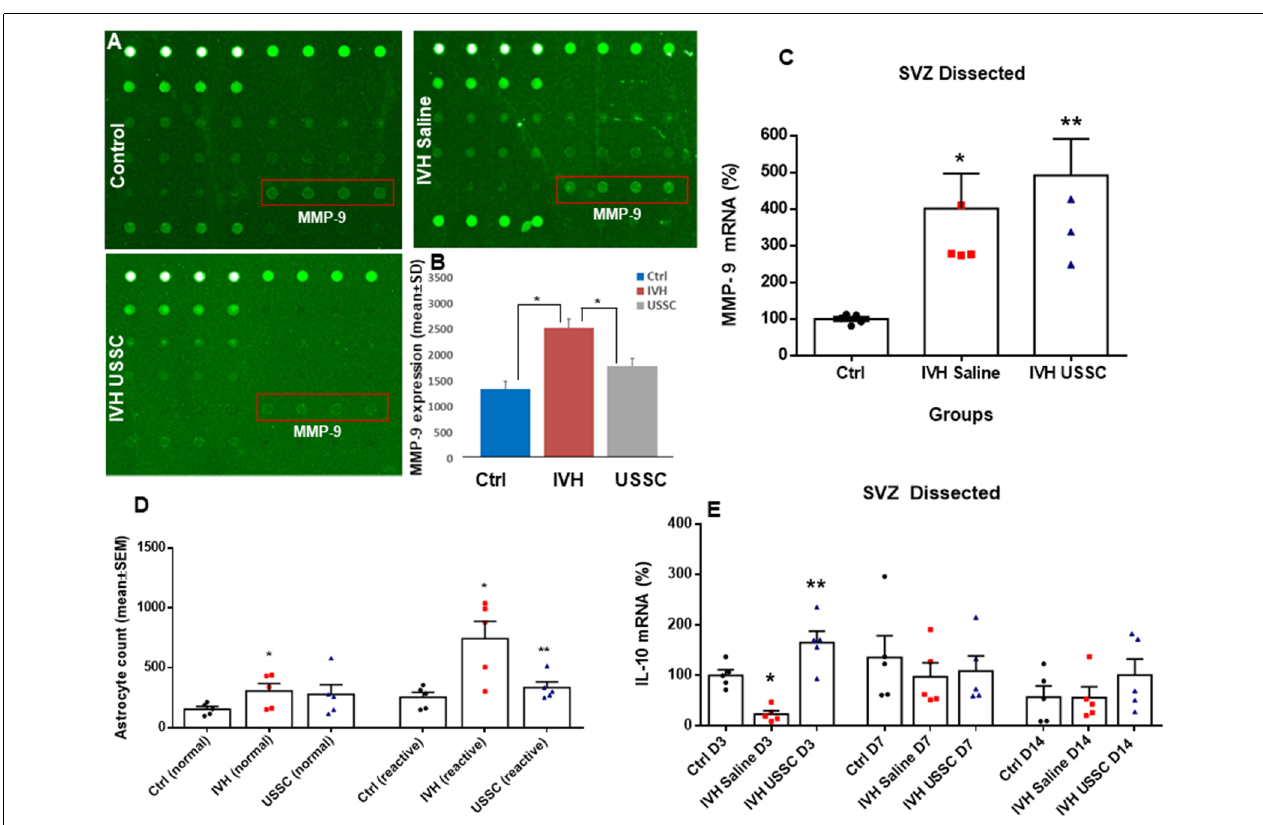
FIGURE 8 | USSC administration suppressed inflammation and enhanced anti-inflammatory cytokine IL-10 mRNA expression in SVZ after PHH. (A) Rabbit cytokine array laser scanned images showing reduced MMP-9 expression after USSC treatment. The representative images are for MMP-9 expression in control, IVH pups with and without USSCs (boxed area = sample loaded as quadruplicates at postnatal day 14). (B) Bar graph shows increased MMP-9 protein expression in IVH pups compared to control pups, whereas USSC treated pups showed significantly reduced expression on postnatal day 14 (* P < 0.05 Ctrl vs. IVH as well as IVH vs. USSC pups, n = 5 pups in each group). The data represent mean ± SD. Assay using rabbit cytokine Array (Ray Biotech., Cat #QAL_CYT-1). (C) Scatter plot with bar graph for TaqMan gene expression assay in microscopic dissected SVZ tissue for MMP-9 mRNA was higher in IVH pups with and without USSC treatment on postnatal day 3 (* P < 0.05 for Ctrl vs. IVH and ** P < 0.05 for IVH vs. USSC group, n = 5 pups in each group). The data represent mean ± SEM; for postnatal day 3. P -values were derived by one-way ANOVA with Tukey’s multiple comparisons test. (D) Total astrocyte cell count showing that normal and reactive astrocytes increased in IVH whereas after USSC treatment, a reduction in reactive astrocyte cell density was observed on day 14 (* P < 0.01 Ctrl vs. IVH and Ctrl vs. USSC for normal astrocytes and * P < 0.05 for IVH vs. Ctrl, ** P < 0.05 for IVH vs. USSC both groups for reactive, n = 5 pups in each group). (E) Bar graphs show TaqMan gene expression assay in microscopic dissected SVZ tissue for IL-10 mRNA. IL-10 mRNA reduced in IVH pups compared to no IVH controls on day 3; whereas USSC injected pups with IVH showed significantly enhanced IL-10 mRNA expression (* P < 0.05 Ctrl vs. IVH, ** P < 0.05 for IVH vs. USSC, n = 5 pups in each group). USSC treated pups showed elevated IL-10 mRNA levels on day 14 (* P < 0.05 USSC vs. other two groups, n = 5 pups in each group), The data represent mean ± SEM; for each group for three postnatal days 3, 7 and 14. P -values were derived by one-way ANOVA with Tukey’s multiple comparisons